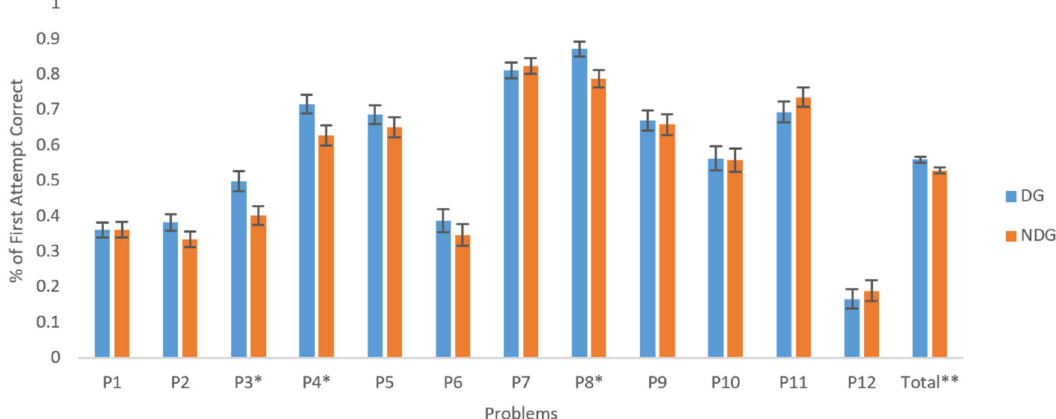
FIG. 2. Percentage of first attempt correct for each problem. The rightmost column is the percentage correct aggregated over all 12 problems. *Difference is significant at the 0.05 level. ** Difference is significant at the 0.01 level. (chi-squared